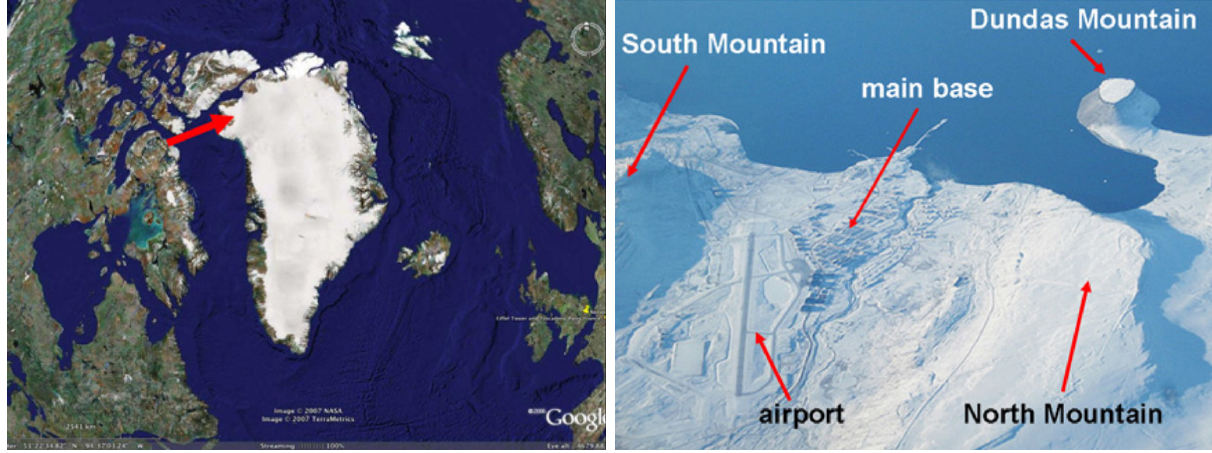
Figure 1. Left: geographical map of Greenland, with the position of Thule Air Base indicated with a red arrow. Right: aerial view of Thule.